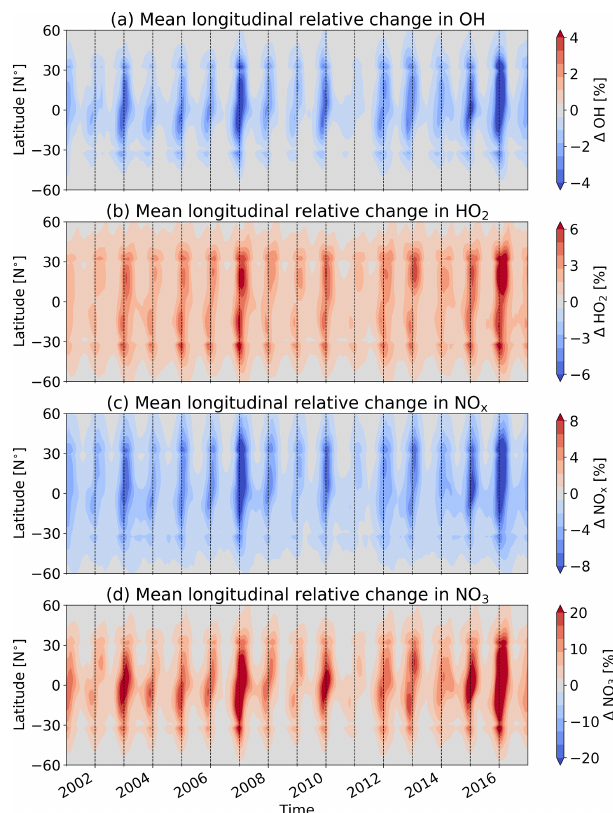
Figure 12. The mean longitudinal relative change in lower strato- spheric (a) OH, (b) HO 2 , (c) NO x , and (d) NO 3 between 2001 and 2016. Results are based on both long-term simulations (simulation REF LONG and FIR LONG ). The lower stratosphere is defined be- tween 147–32hPa (about 13–24km) above 30 ◦ in latitudinal direc- tion and between 100–32hPa (about 17–24km) below 30 ◦